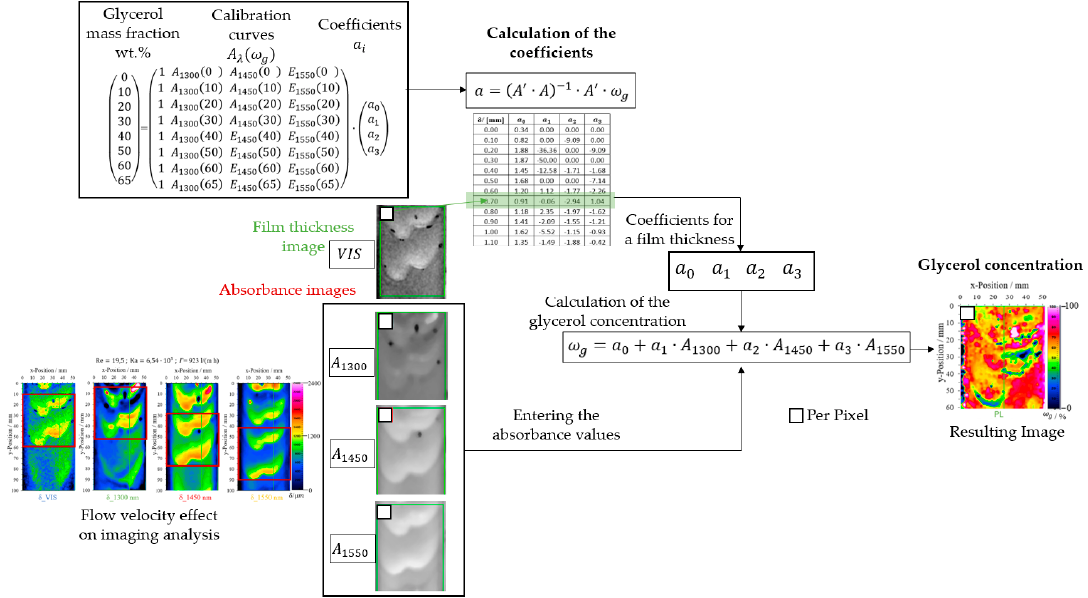
Figure 10. Workflow scheme for determining glycerol mass concentration in falling films using multiwavelength image analysis.